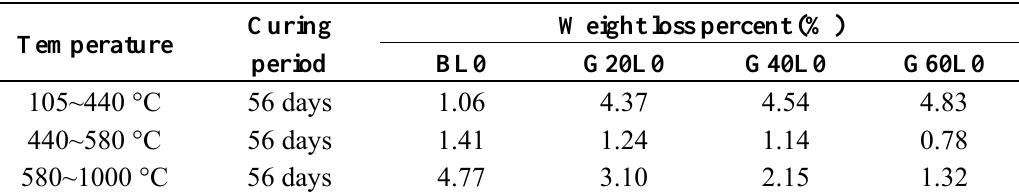
Table 8. Weight loss of the specimen with slag admixture under different temperature prior to leaching.